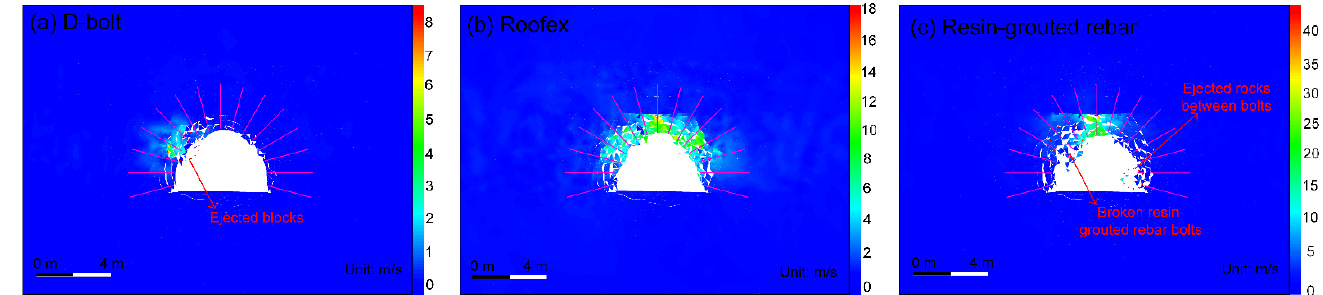
Figure 12. ( a ) Simulated displacement vectors of the surrounding rock masses along the tunnel sup- ported by different types of rockbolts. ( b ). Comparison of the deformation of the tunnel supported by different types of rockbolts.